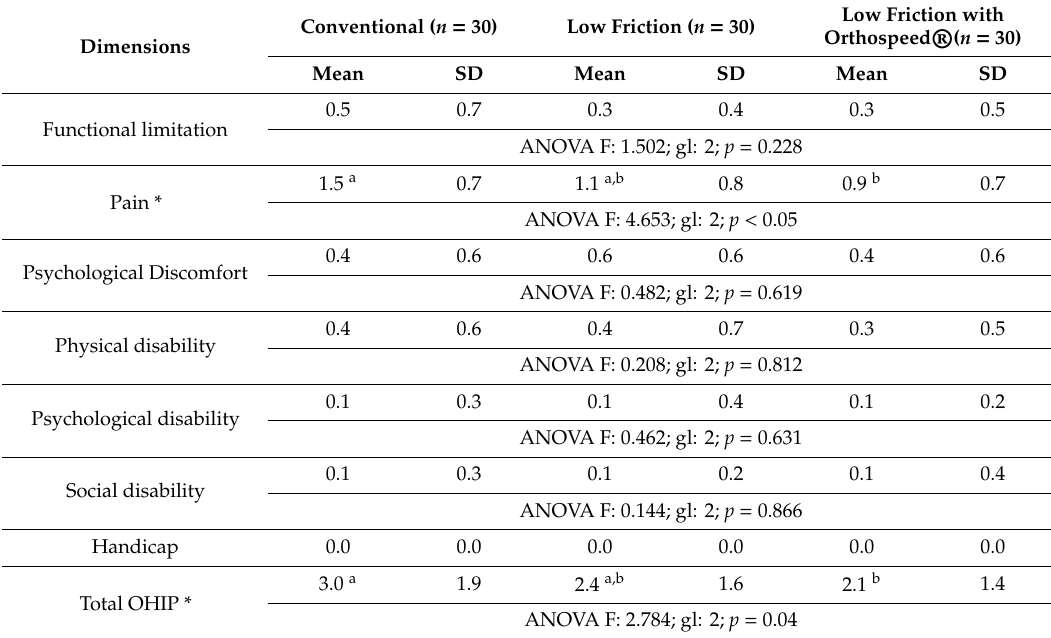
Table 4. Comparison of the impact on the dimensions of oral quality of life.